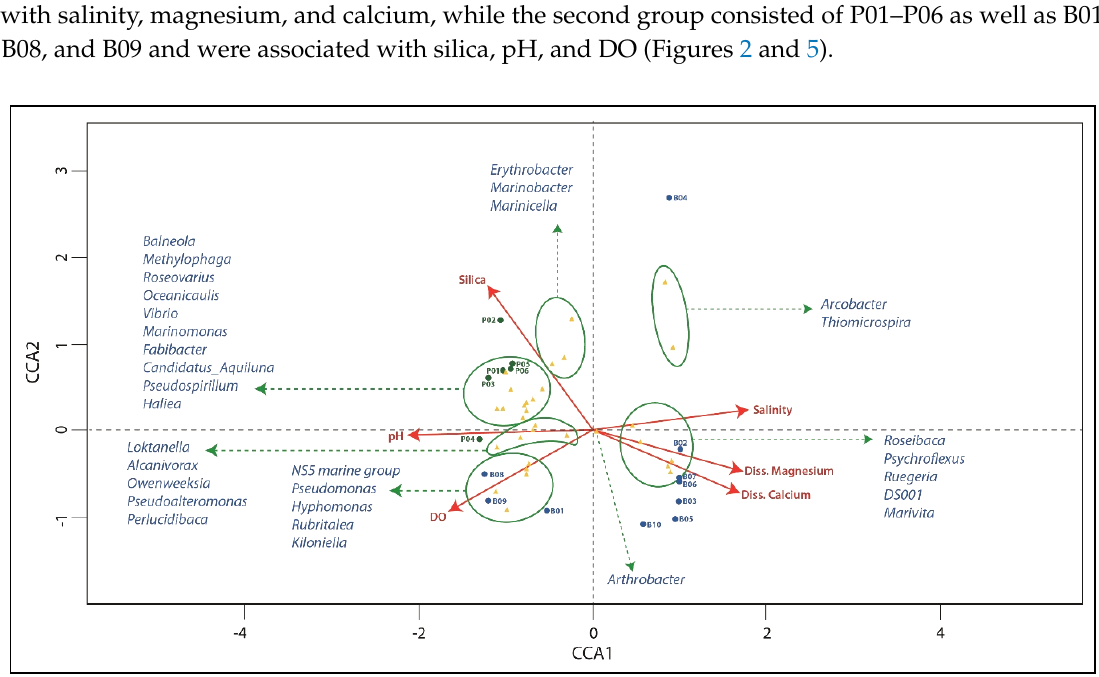
Figure 5. Canonical correspondence analysis (CCA) of the distribution of the most abundant genera with respect to six environmental variables. Samples are indicated with B for La Brava (blue dot) or P for La Punta (green dot). Genera are represented by yellow triangles and environmental variables by red arrows (average relative abundance of the genera > 0.5%).